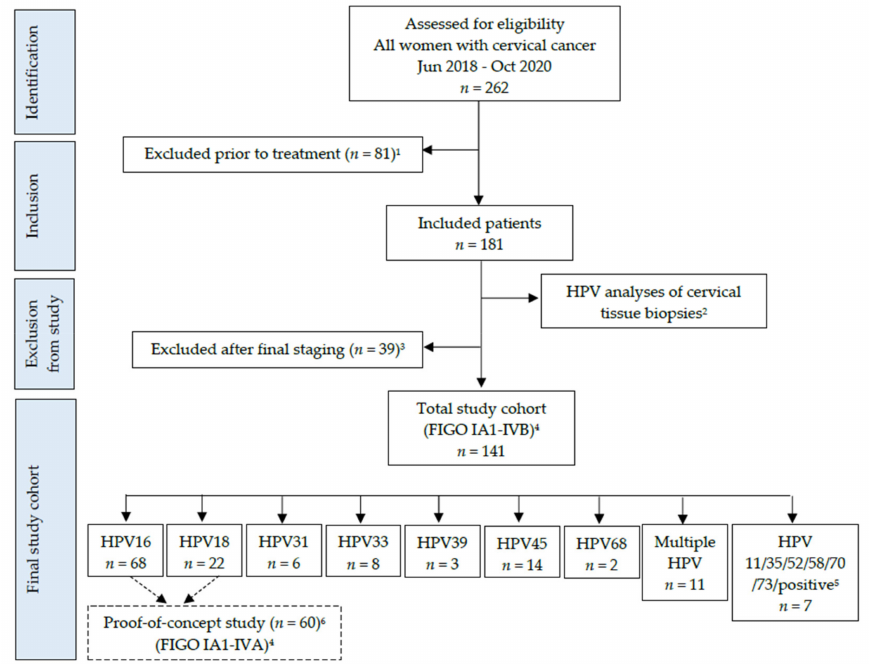
Figure 1. Flowchart of included cervical cancer patients. 1 For exclusion causes, see Supplementary Table S2. 2 Cervical biopsies were analyzed with the INNOLiPA HPV Genotyping Extra II assay (INNO-LiPA) (Fujirebio Europe, Ghent, Belgium). 3 For exclusion causes, see Supplementary Table